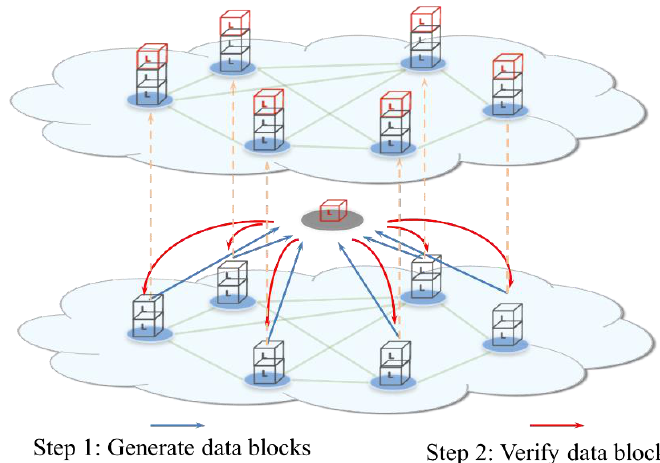
Figure 2. Workflow of blockchain technology.